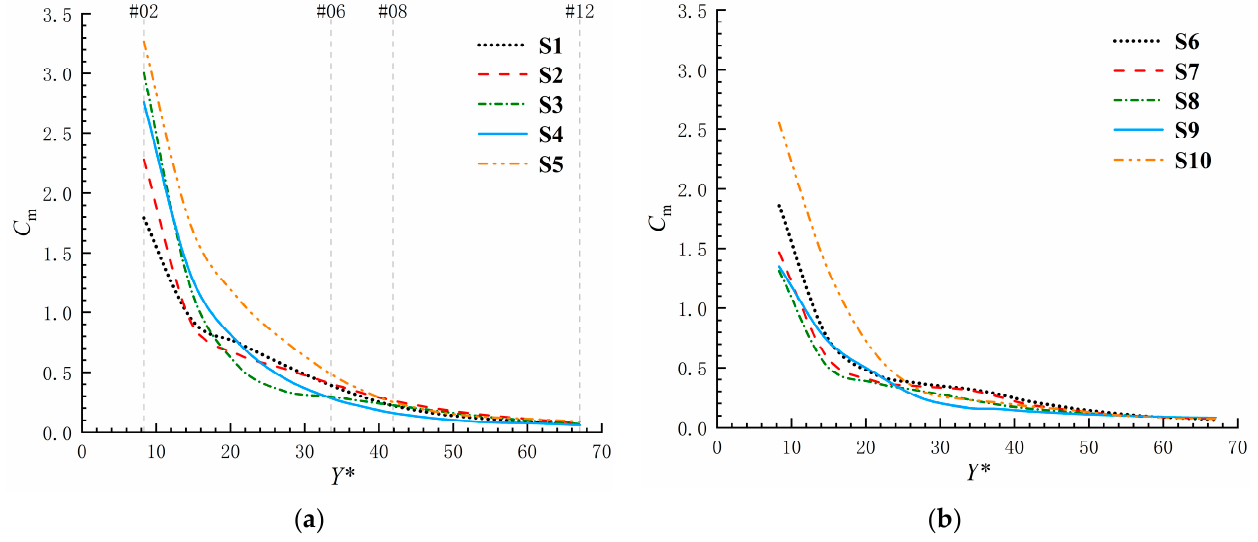
Figure 18. Normalized root mean square of concentration C m in different scenarios along the channel. ( a ) Case S1–S5; ( b ) and Case S6–S10.